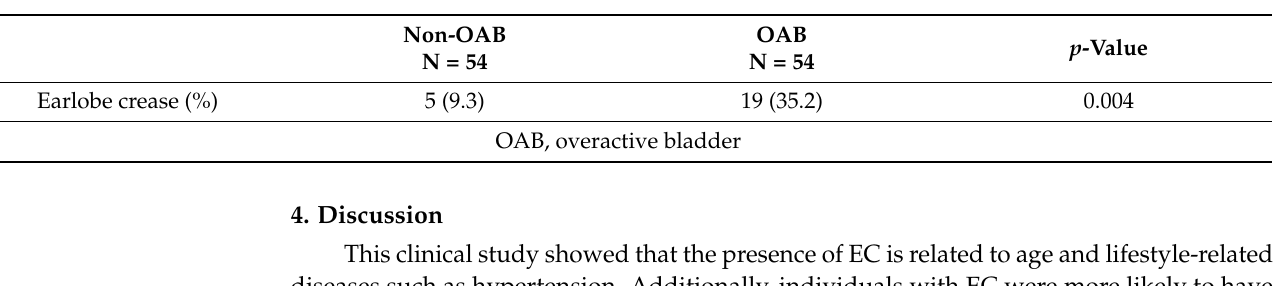
Table 8. Differences in OAB between the presence and absence of EC based on propensity score matching